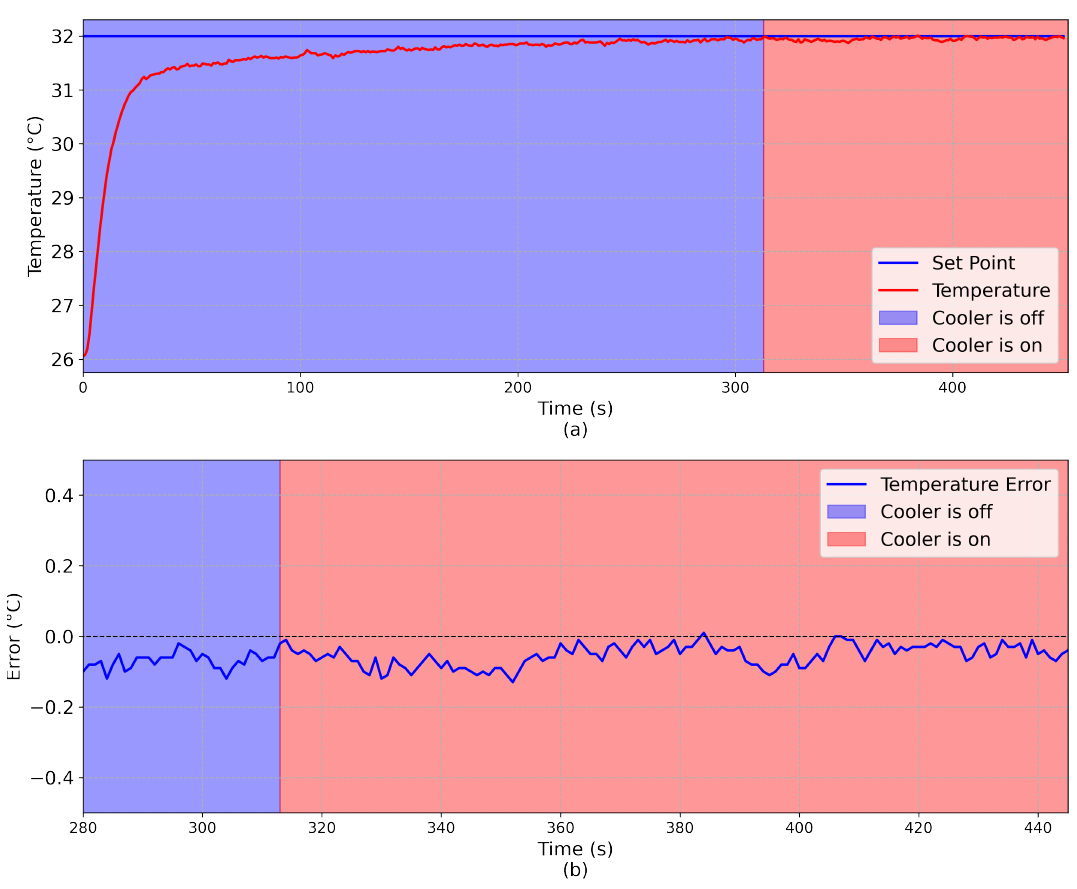
Figure 12. PID: ( a ) Comparison between the set-point (blue line) and the emulated temperature (red line). ( b ) Error (E = Set-Point - Emulated Temperature) during the noise test. The region with a blue background indicates that the cooler is off and the region with a red background indicates that the cooler is